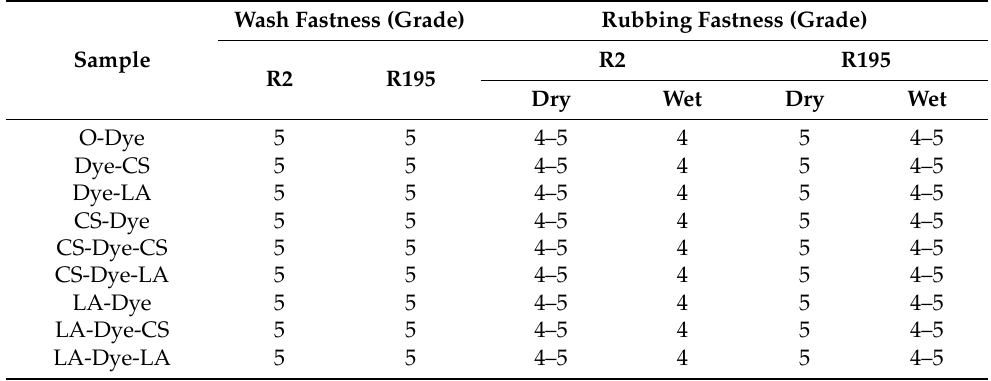
Table 5. Colorfastness to washing and rubbing of the original and mercerized cotton fabrics. Wash Fastness Sample